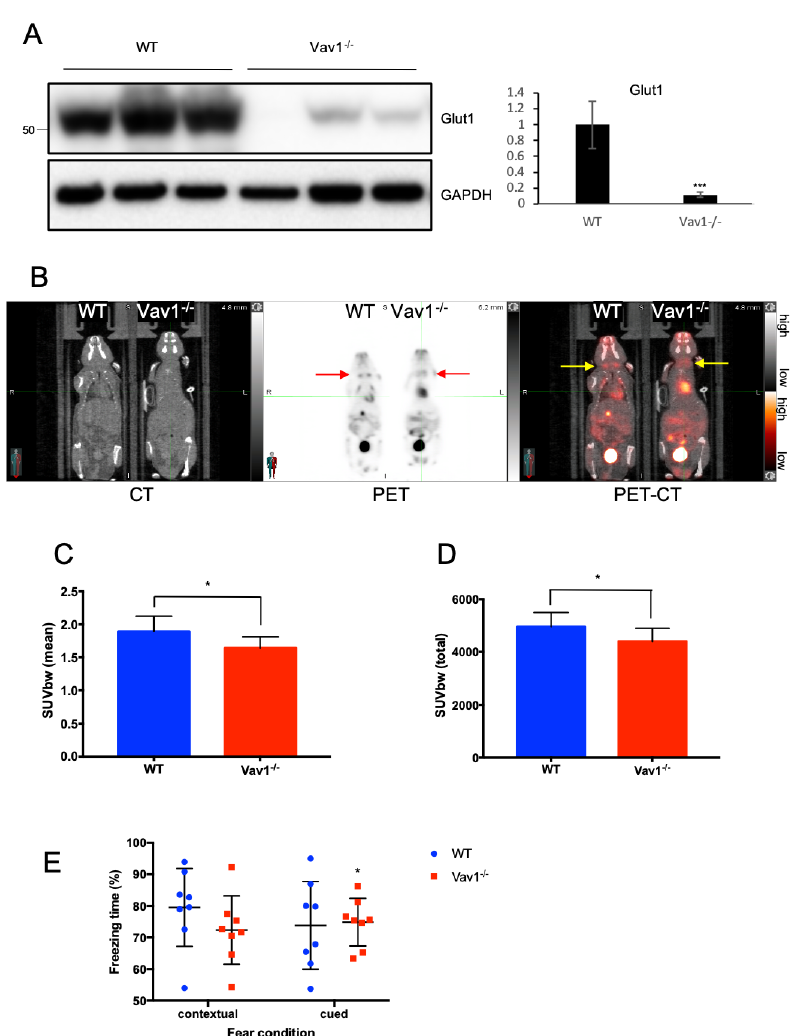
Figure 4. Vav1 deficiency downregulates glucose distribution in the brain. ( A ) The total lysate of mouse brain was subjected to Western blot to measure GLUT-1 protein expression levels ( n = 3/group). Mean ± SD, *** p < 0.001. ( B ) Wild type or endothelial Vav1-deficient mice were subjected to a PET/CT scan to measure the distribution of 18F-FDG. Mice fasted for 12 h before intravenous injection of 18F-FDG (Arrows indicate brain hemispheres). One hour after 18F-FDG injection, the whole body of mice was scanned. The scanned signal in brains was normalized and then numerated as mean ( C ) and total ( D ) standardized uptake value body weight (SUVbw) ( n = 10/group). ( E ) Wild type or endothelial Vav1-deficient mice were subjected to a fear conditioning test. Both contextual and cued conditions were given to measure the percentage of time in a frozen state ( n = 10/group). Mean ± SD, * p < 0.05. All mice were female and eight weeks old.